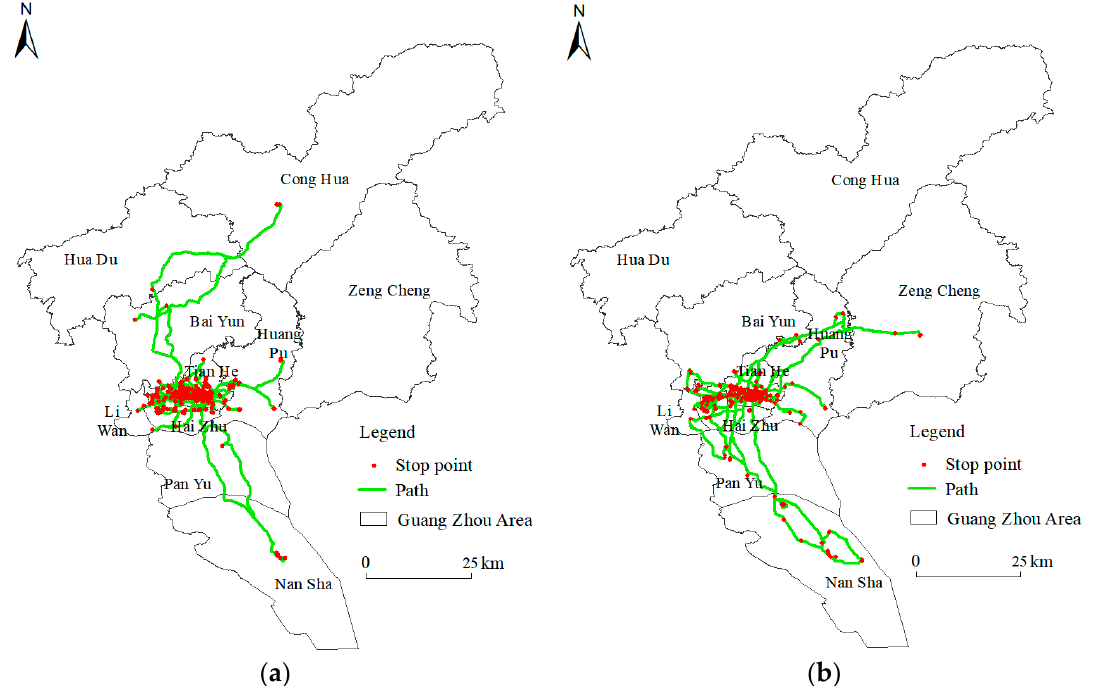
Figure 1. Trajectories of residents’ daily activities. ( a ) Workday; ( b ) weekend.